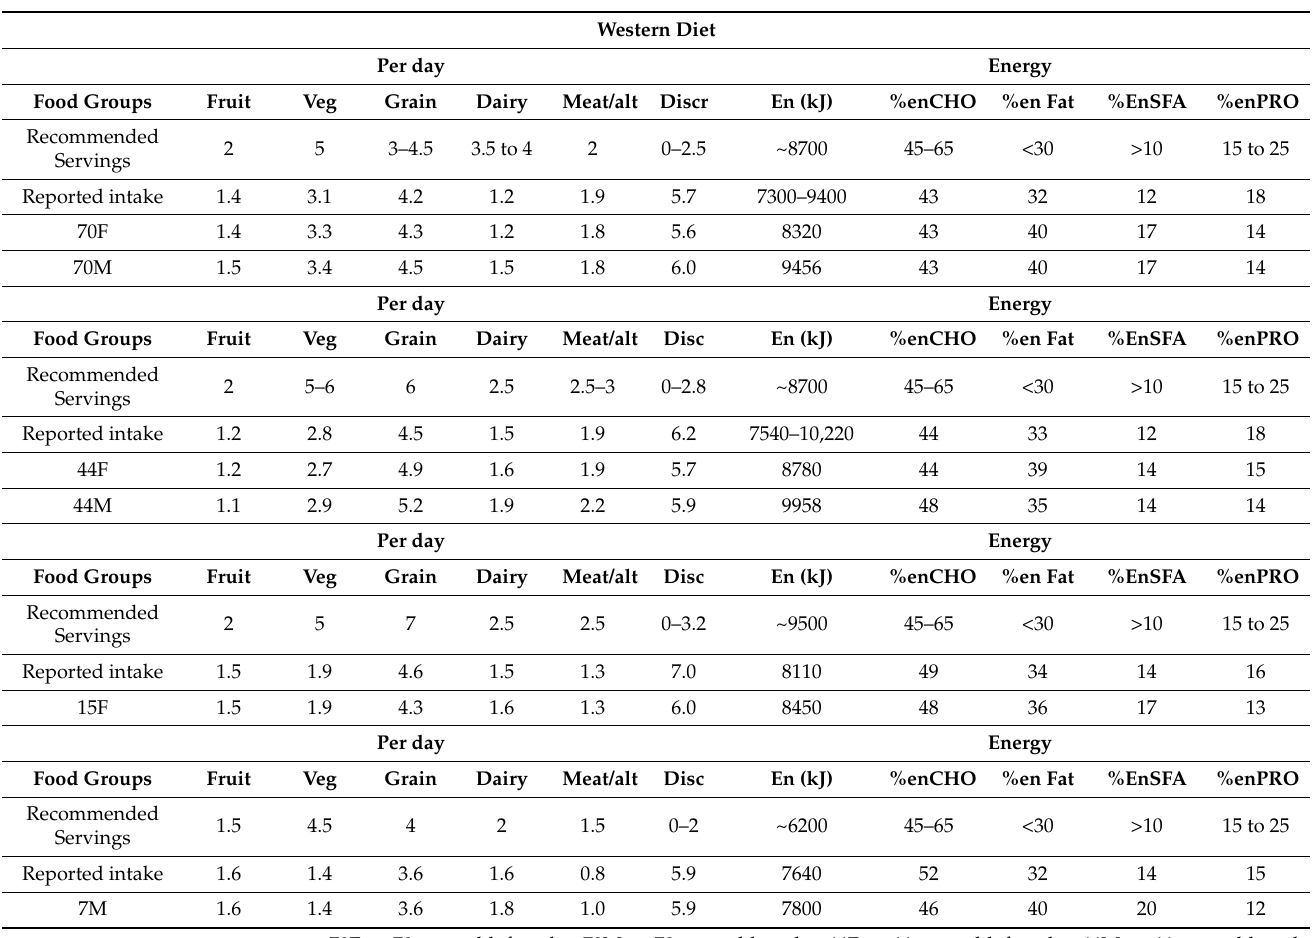
Table 6. Overview of average daily food group and discretionary intake and energy contributions for the Western Diet food